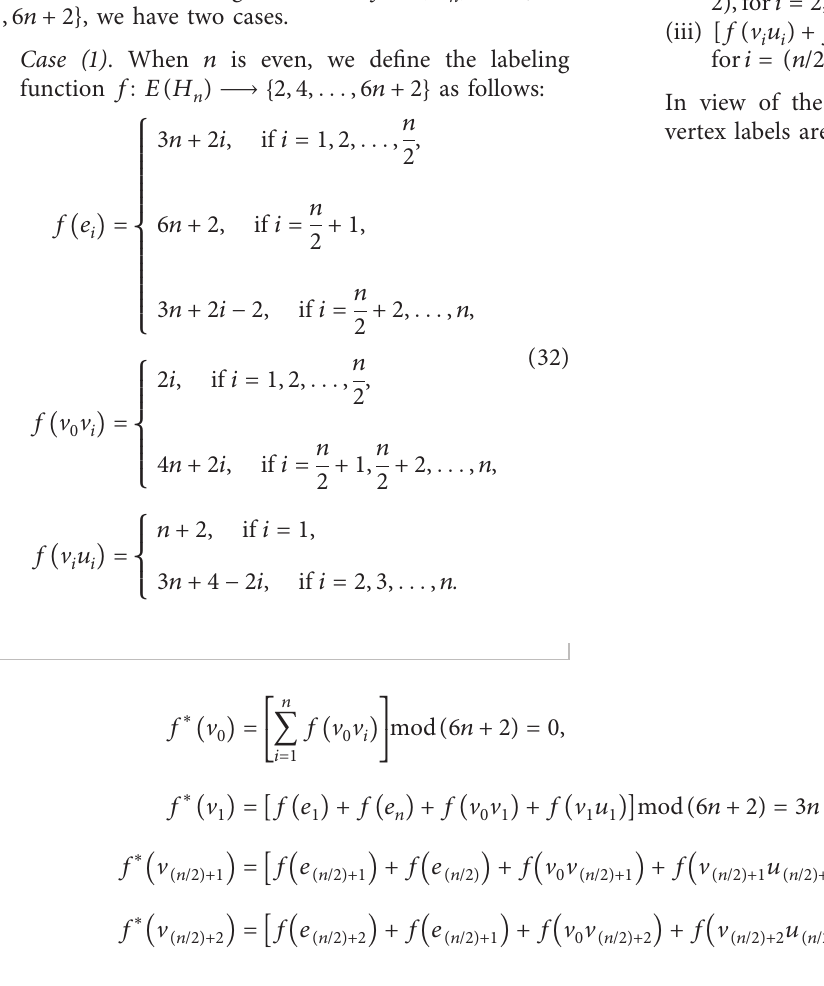
. (b) 2-edge even graceful labeling of C 9